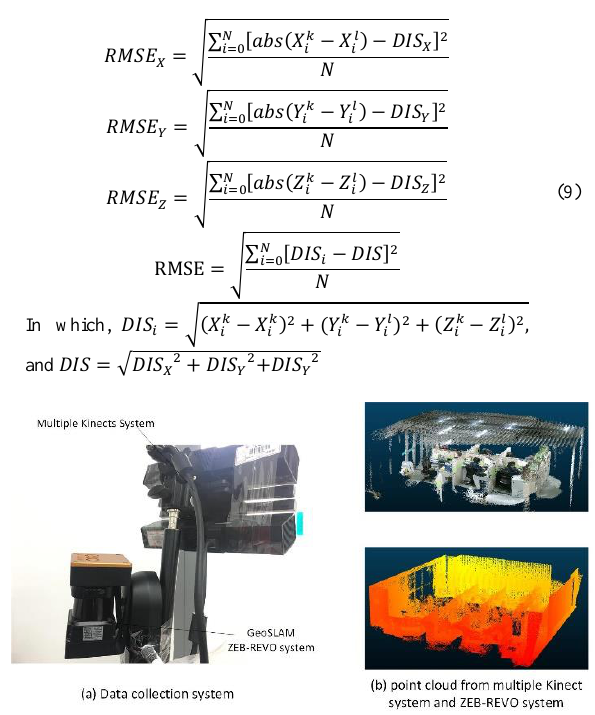
Figure 5. Data collection system and the point cloud of ZEB- REVO and RGB-D system